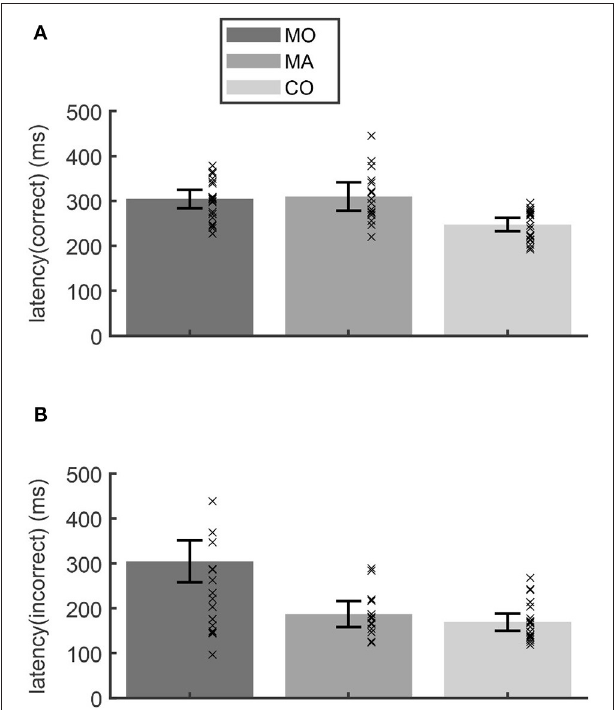
TABLE 2 | Summary of saccade characteristics for the reflexive and intentional saccade paradigms. Paradigm Group Gain